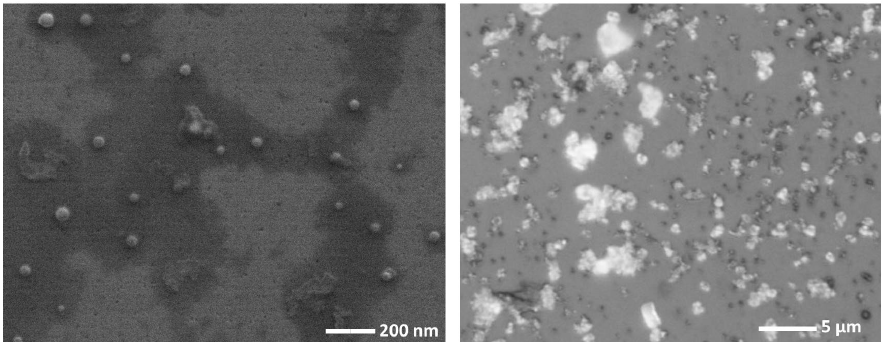
Figure 1. SEM image of LN particles obtained by laser ablation method ( left ) and optical microscope image of the LN powder ( right ).